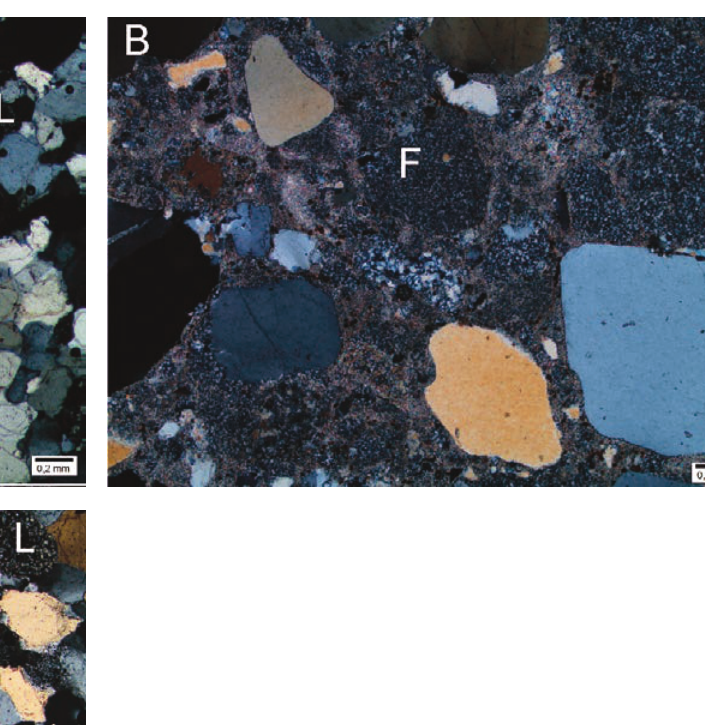
Figure 5 - Photomicrographs of sandstones. (A) Lithic arenite with rounded and subrounded quartz grains, quartz overgrowths (arrows), and lithic (L) fragments. (B) Lithic arenite with mono and polycrystalline quartz grains and broken and sericitized feldspar (F) crystals set in a sericitized matrix. (C) Quartz arenite with little matrix irregular to subrounded quartz grains and rare lithic fragments